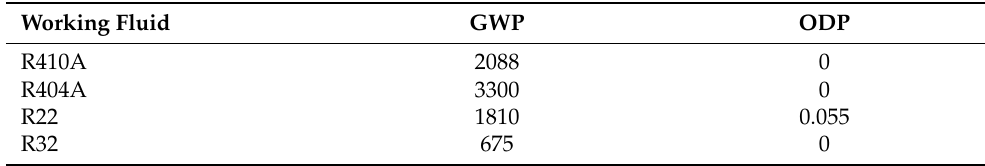
Table 2. The environmental properties of selected refrigerants